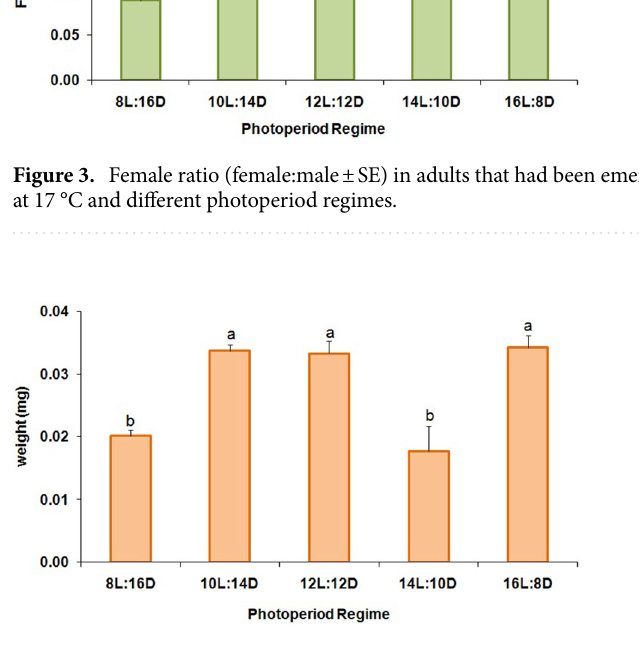
Figure 4. Larval weight (mg ± SE) of P. interpunctella larvae reared at 17 °C and different photoperiod regimes (means followed by the same letter are not significantly different; HSD test at 5%).